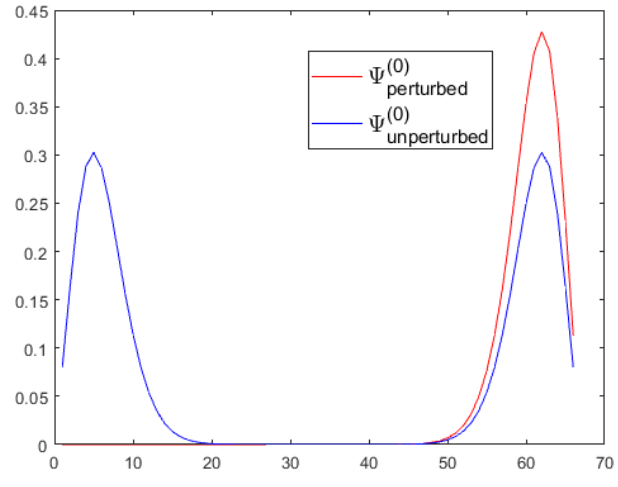
Figure 12: Corresponding ground state (in red) of the perturbed Hamiltonian + ∆ V h CW is already localized for N = 65 , b = 9 / N, c = 1 / 45 , d = 0.4 , J = 1 N N and B = 1 / 2 . Localization takes place on the right side of the well, since the flea raises the potential on the left